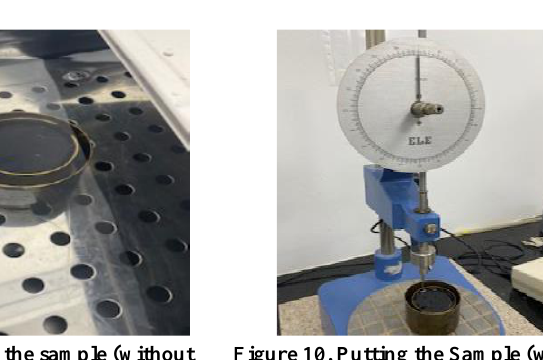
Figure 8. Preparing the Bitumen Figure 9. Placing the sample (without Sample polymer) in the water bath